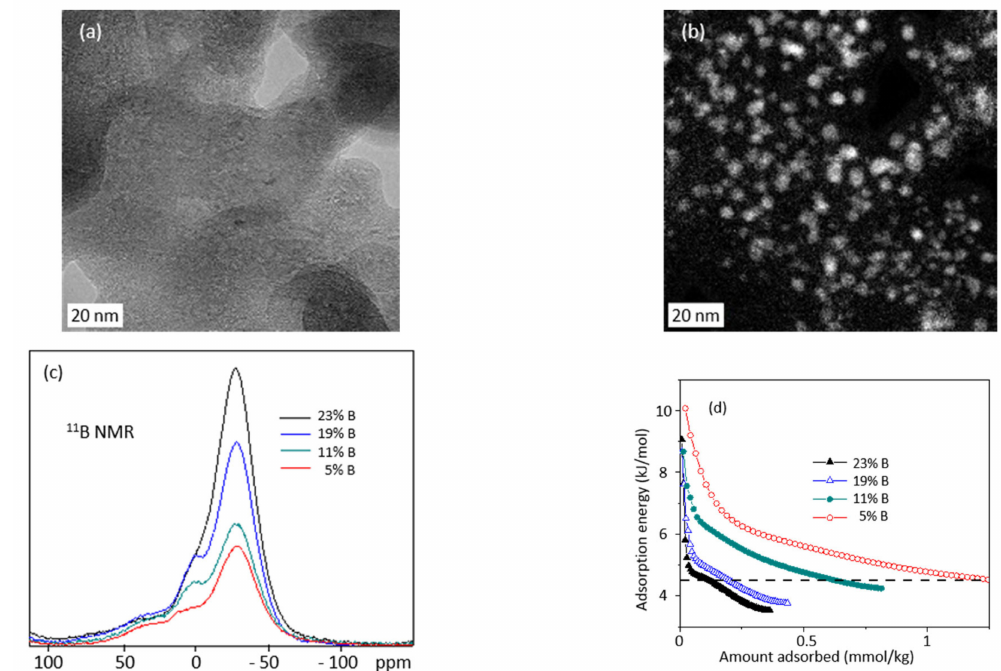
Figure 6. ( a ) HR TEM and ( b ) EELS images of the same fragment of sample containing 23 wt% of boron; ( c ) 11 B HR spectrum of samples containing 5, 11, 19, and 23 wt% of boron. The 11 B chemical shifts were referenced to H 3 BO 3 0.1 M solution; the MAS frequency of 10 kHz was used; ( d ) hydrogen adsorption energy in a function of gravimetric storage calculated from a pair of isotherms at 77 and 87 K (horizontal dashed line indicates 4.5 kJ/mol level typical for pure activated